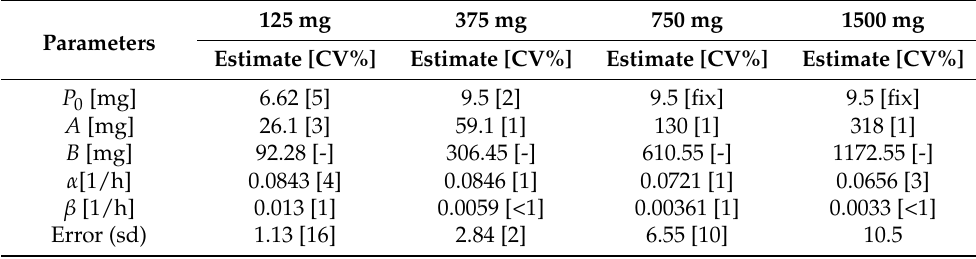
Figure 4. Goodness-of-fit plots of the in vitro release model stratified on the dose level. For each dose level, model predictions are plotted against individual experimental data. 3.1.2. In Vivo Release Model The introduction of the inhibitory function on the exponential rate terms of the in vitro release model allowed the relationship between the in vitro and the in vivo proges- terone release profile to be captured well. For each dose level, the value of the in vitro–in vivo inhibitory factor 𝛾 was identified by solving Equation (6). Results are reported in Table 6. Table 6. Estimates of the 𝛾 parameter. Dose [mg]